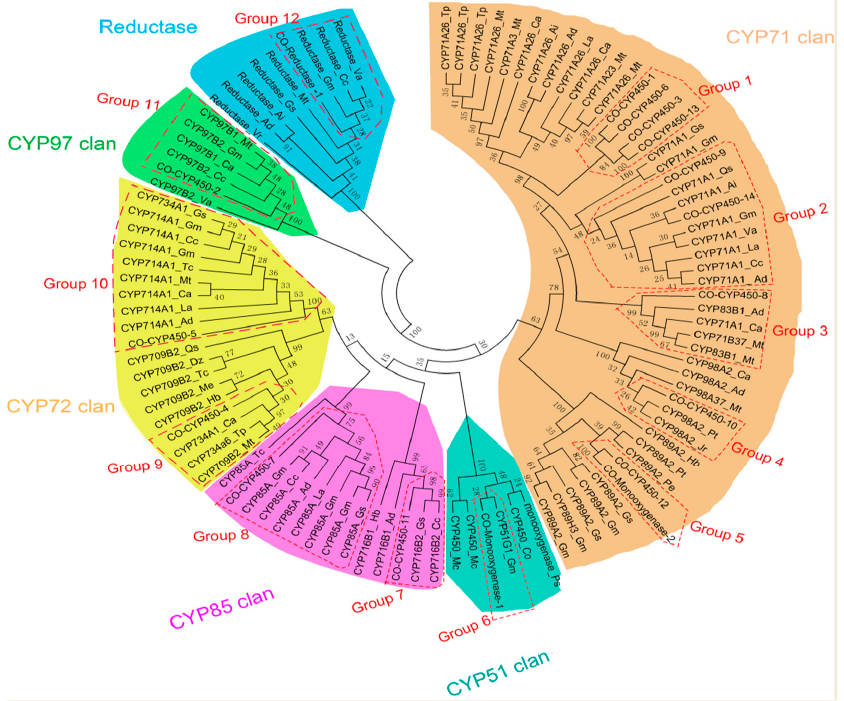
Figure 7. Phylogenetic analysis of seed ‐ specific candidate transcripts coding CYPs associated with the